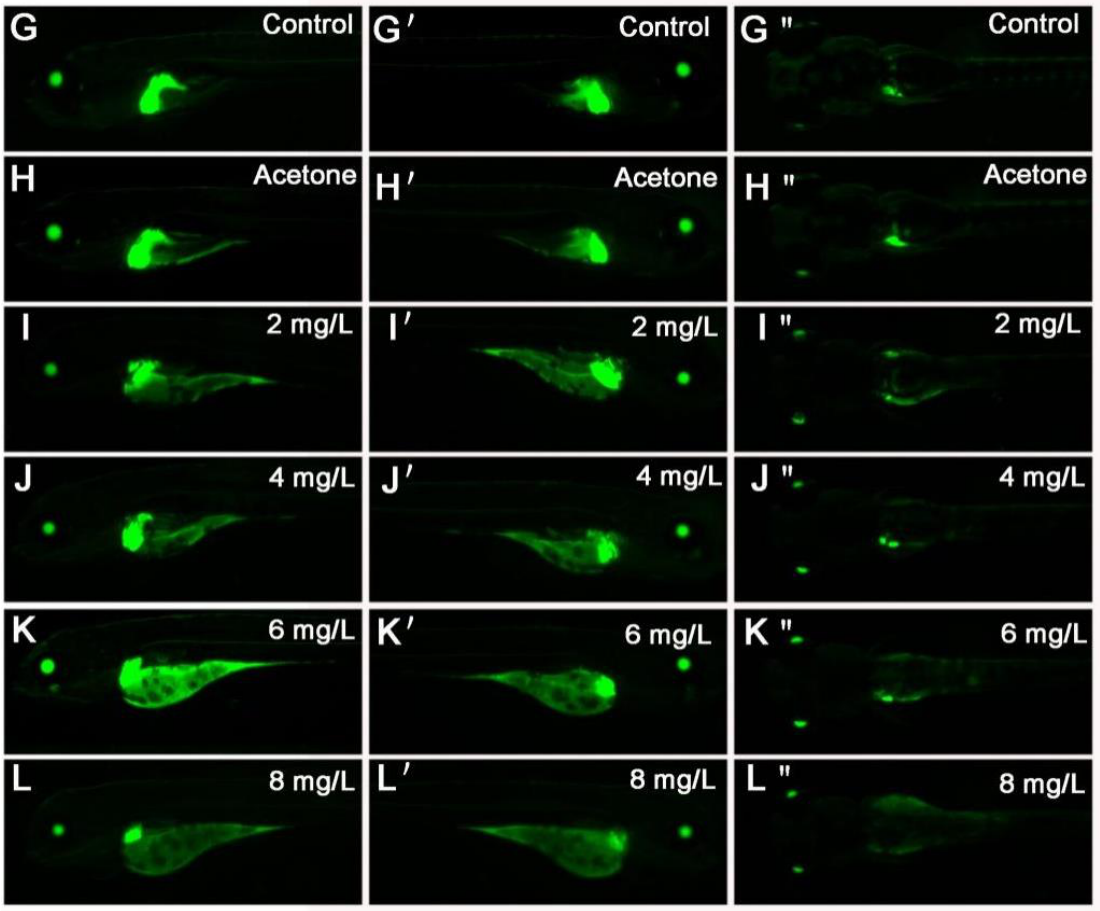
Figure 5. 2,4-DNT inhibited the development of hepatic primordium in Tg(apop:GFP) larvae at 5